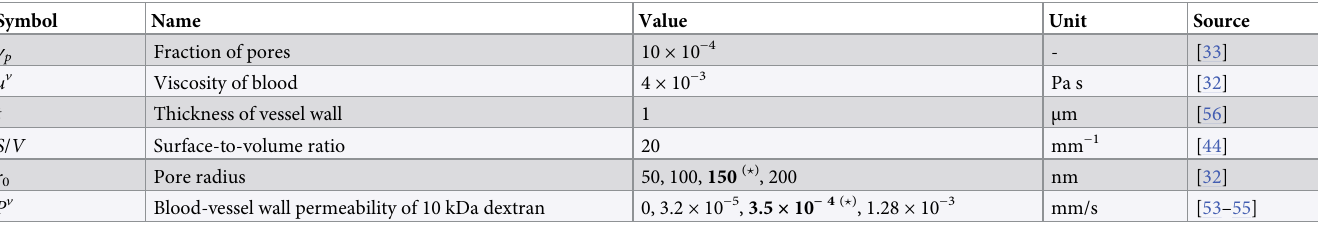
( ? ) The bold value marks the default value used for the nanoparticle transport study in Section